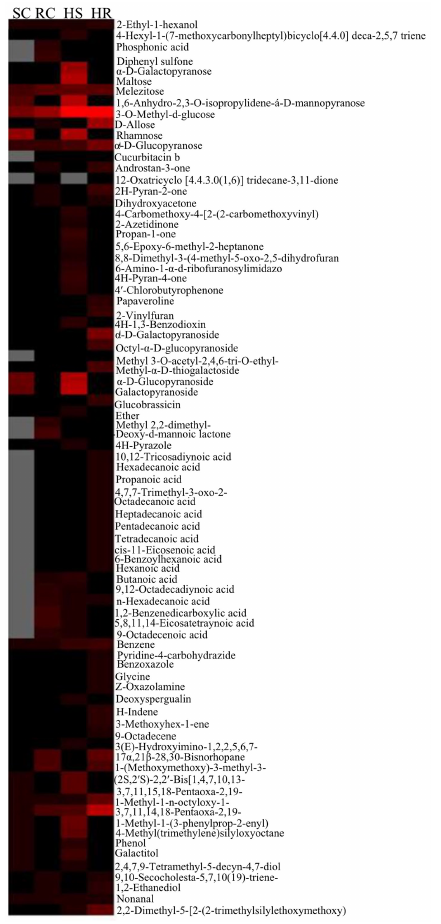
Figure 7. Hierarchical cluster analysis of metabolites accumulated in different resistant and suscepti-